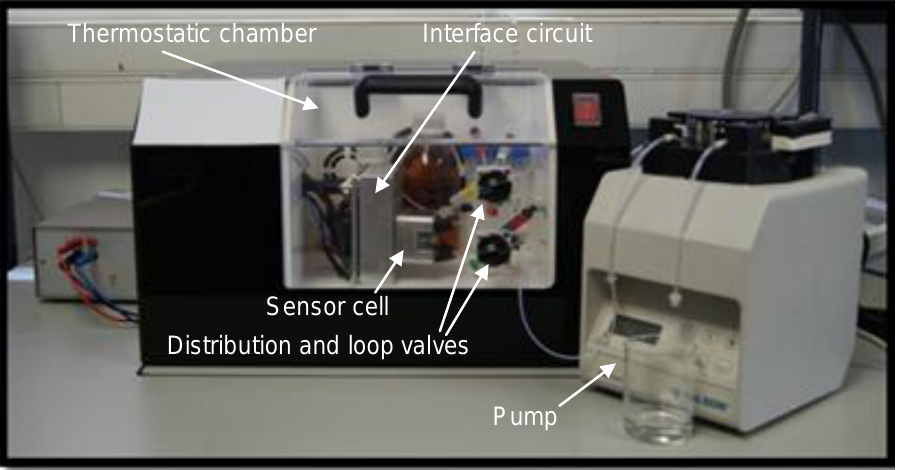
Figure 5. Experimental